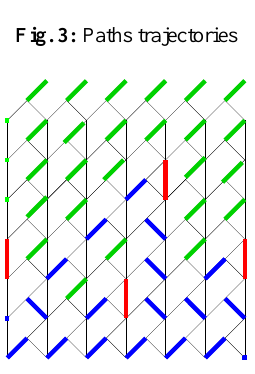
Fig. 3: Paths trajectories